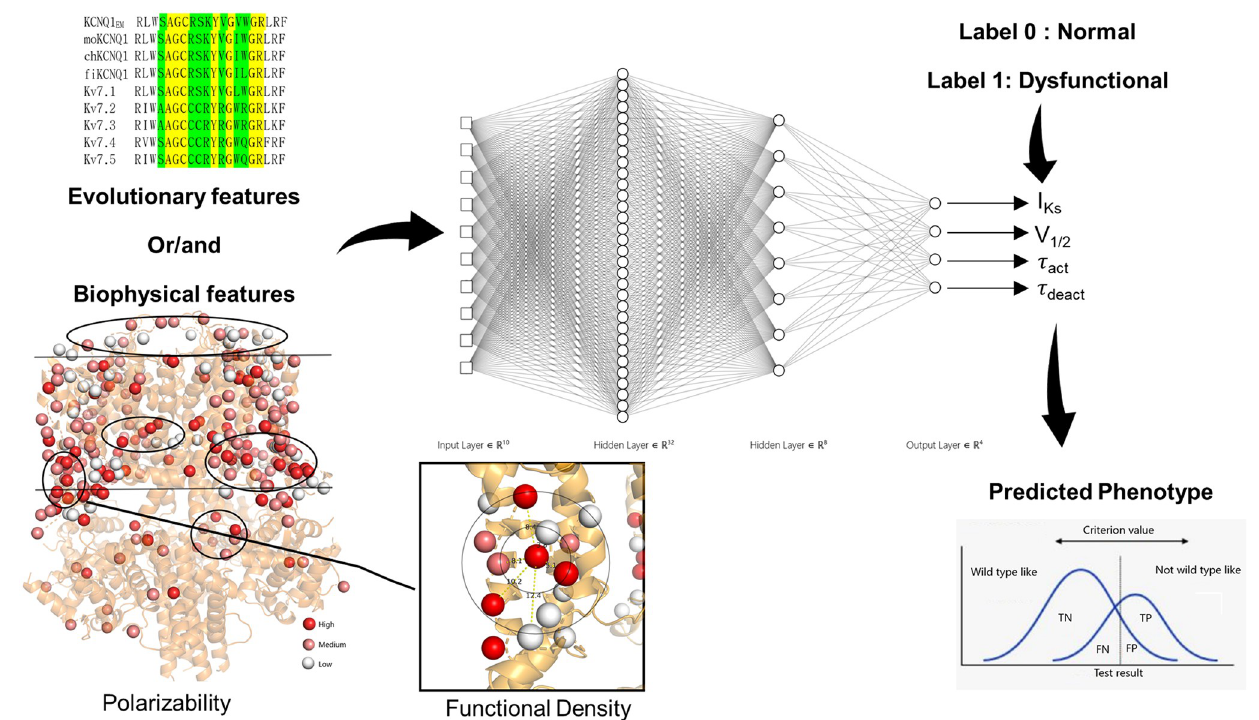
Fig 1. A Schematic flowchart of the ANN